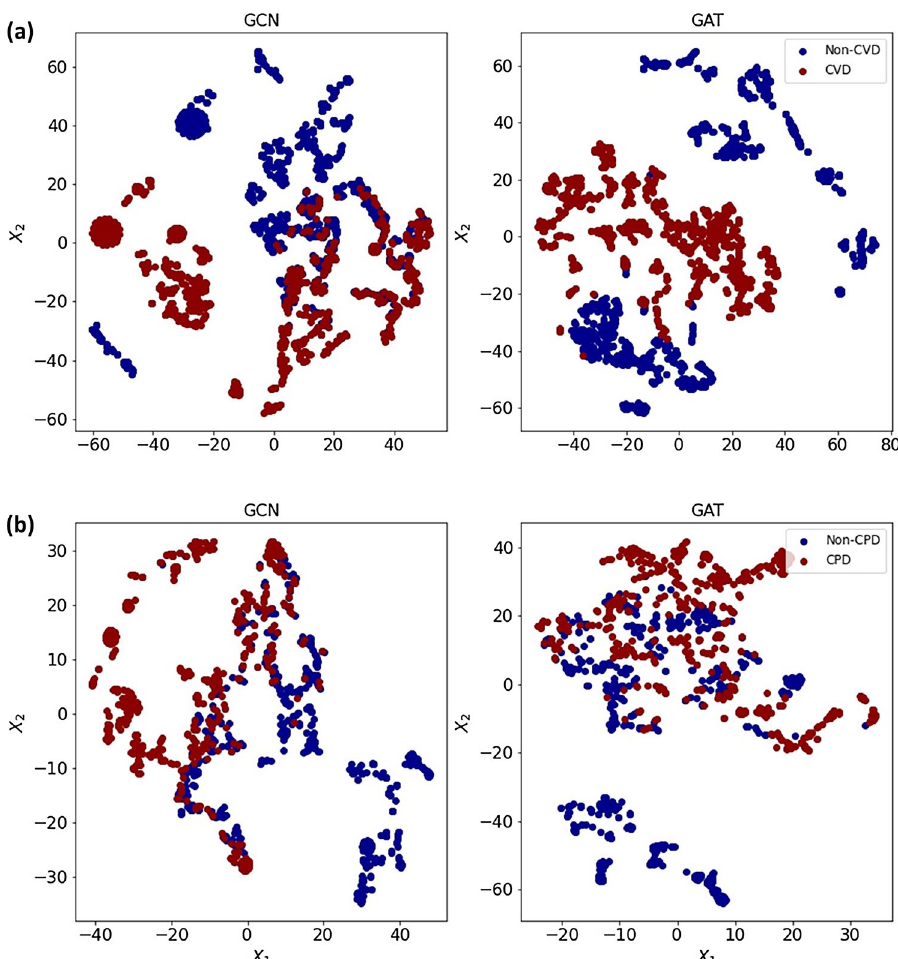
Figure 3. ( a ) t-SNE visualisation of GNN-Based models embeddings for CVD. ( b ) t-SNE visualisation of GNN-Based models embeddings for CPD. Node colours denote